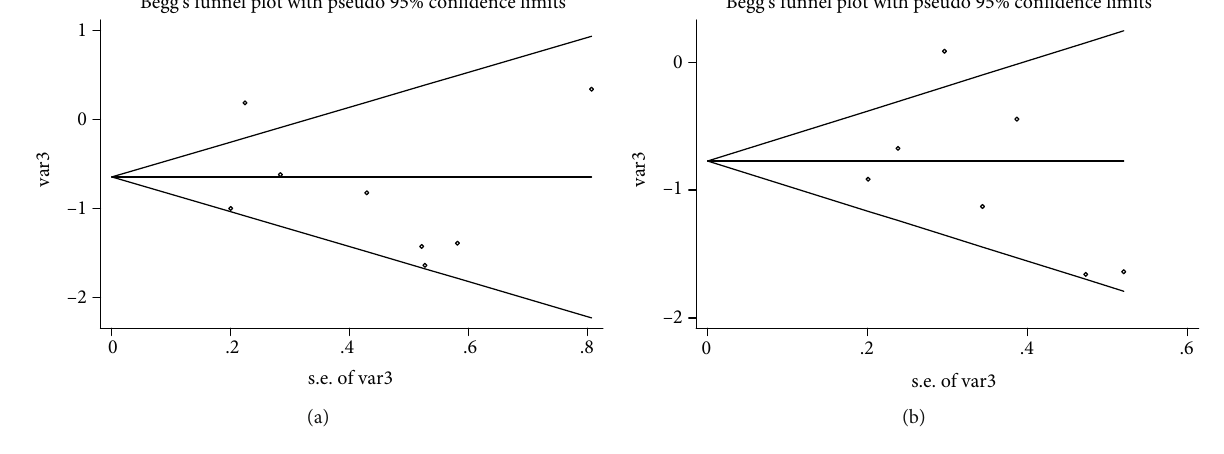
Begg's funnel plot with pseudo 95% confidence